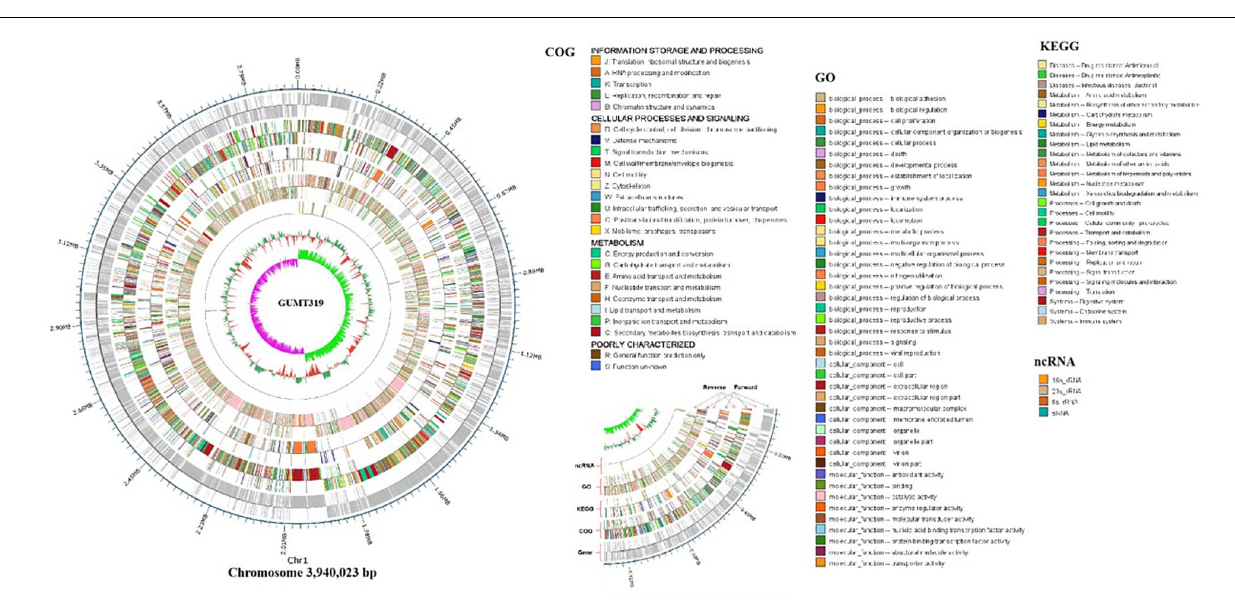
FIGURE 2 | Circular genome map of B. velezensis GUMT319. The scale is shown in the outermost circle. The second and third circles indicate genes in forward and reverse orientations, respectively. The outer to inner rings represent forward and reverse DNA sequences of protein-coding genes annotated according to COG, KEGG, and GO databases and ncRNA. The 10th circle shows the GC content, and the 11th circle shows the GC skew in green and